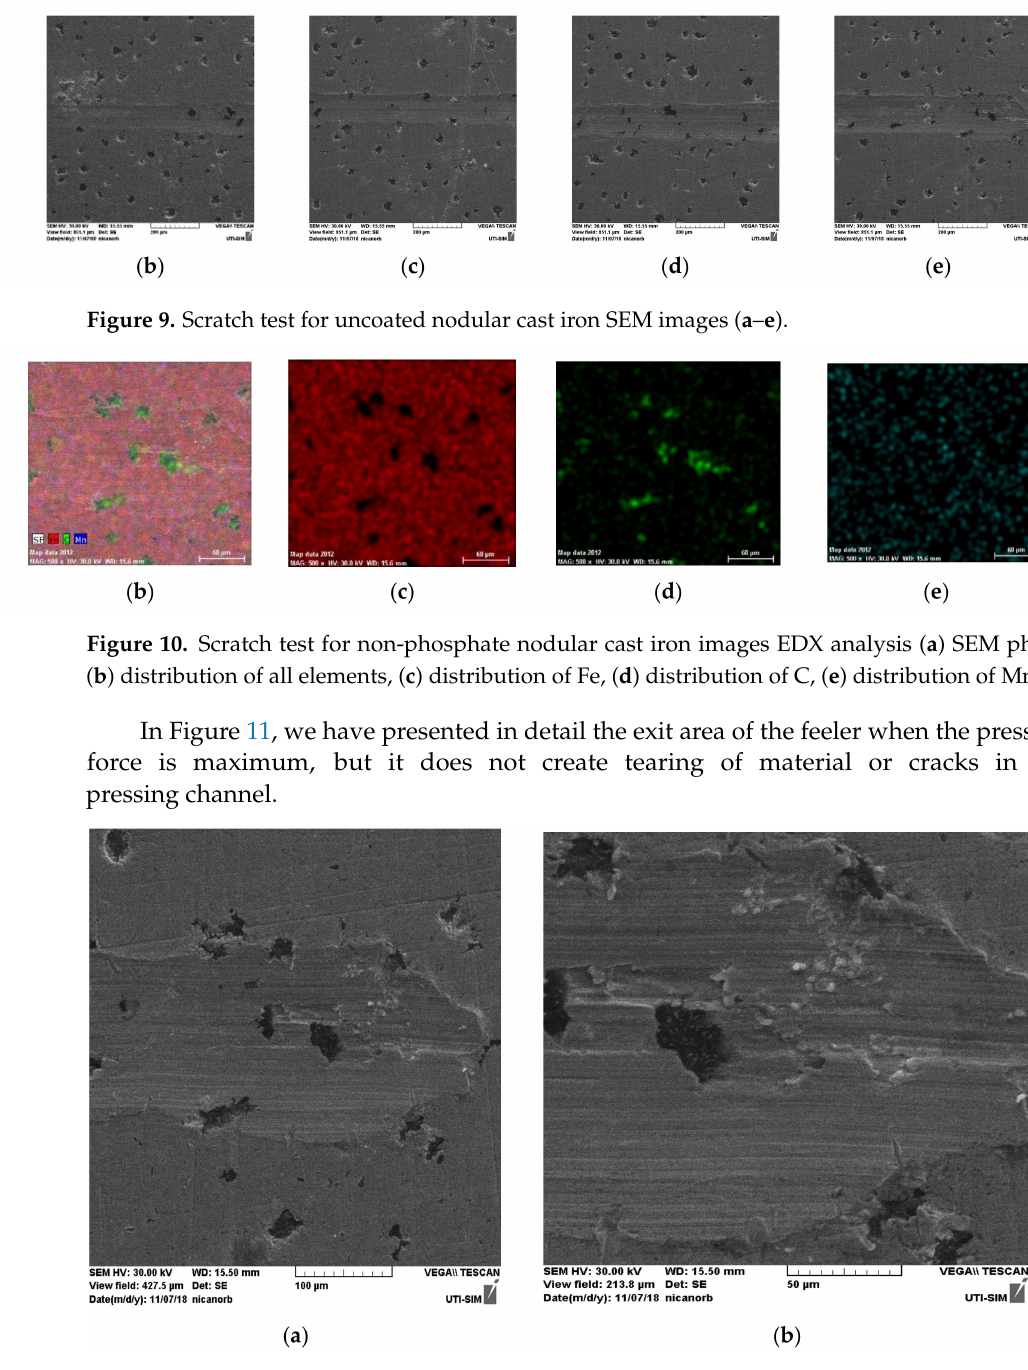
Figure 11. Scratch test: ( a ) probe output; ( b )